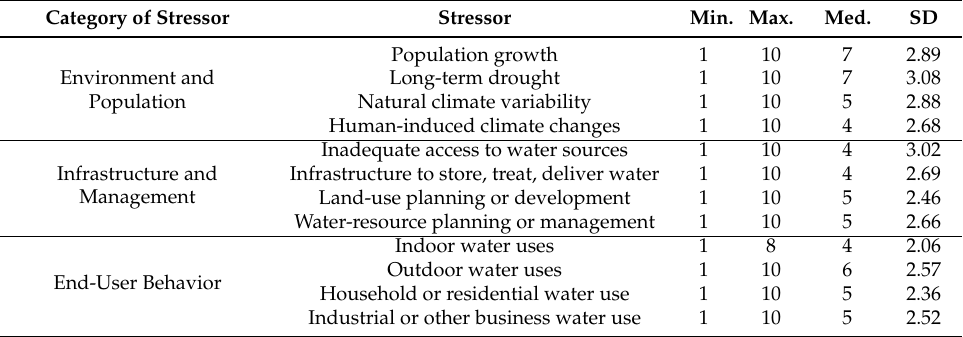
Table 1. Stressors listed for consideration in survey with descriptive statistics (Minimum, Maximum, Median, Standard